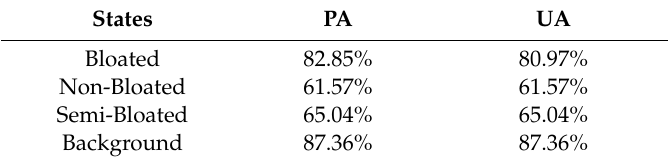
Table 2. Precision Accuracy (PA) and User Accuracy (UA) of each of the 4 state